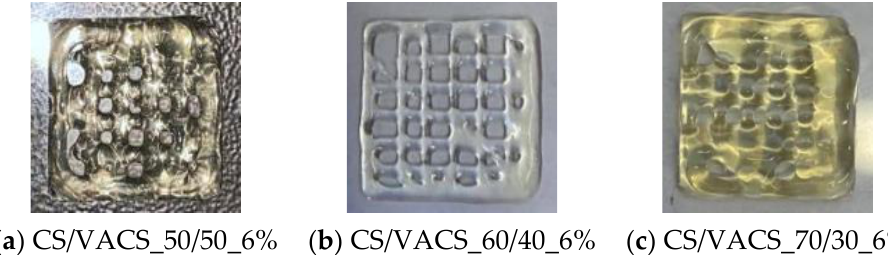
Figure 1. The 3D-printed multilayered scaffolds of CS/VACS 6% w/v ( a ) 50/50, ( b ) 60/40, and ( c ) 70/30.